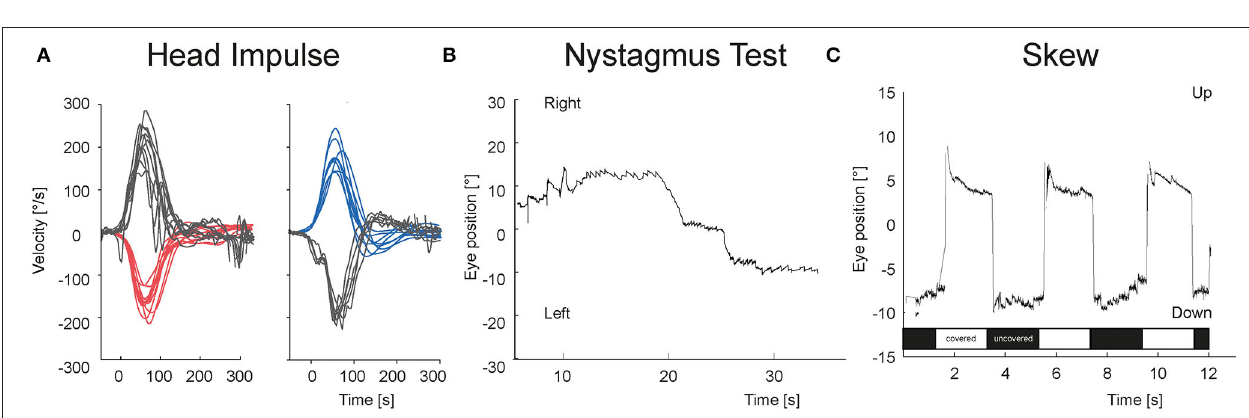
FIGURE 4 | VOG eye recordings of a patient with stroke. (A) vHIT is bilaterally normal without any corrective saccades. (B) Nystagmus is changing the beating direction at right and left gaze. (C) There is a vertical eye movement of 11 degrees in the test of skew during the transition from covered (white bar) to uncovered (black bar) right eye and vice